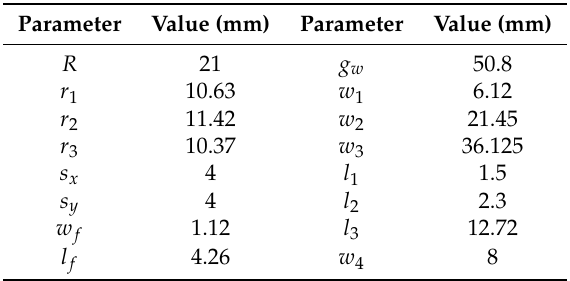
Table 1. Optimized geometrical parameters of proposed